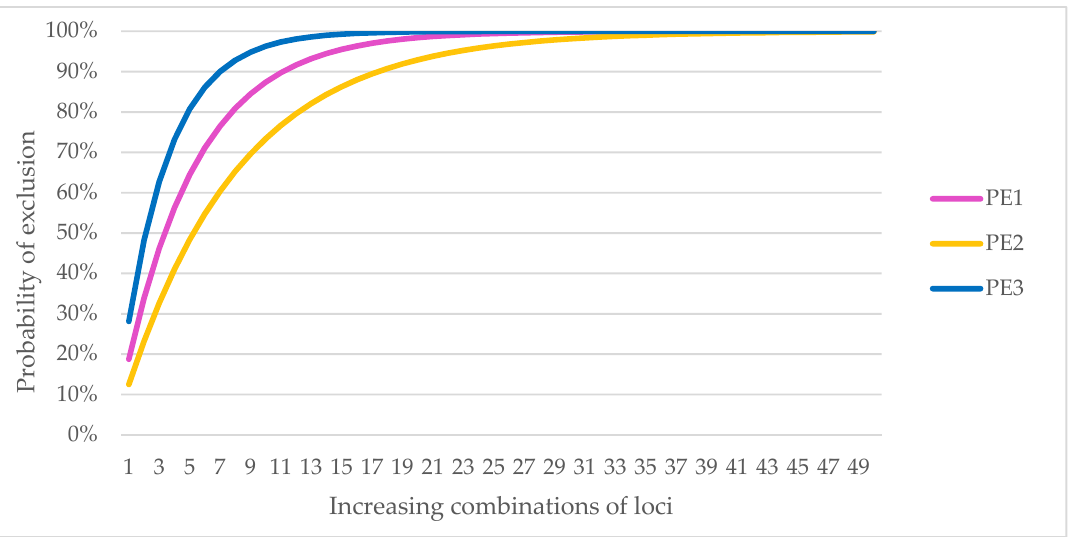
Figure 1. Probability of exclusion for an increasing number of loci. PE1, when the other parent is known; PE2, when one of the parents is known, but the genotype of the other is not available; and PE3 for the exclusion of the putative parental pair.